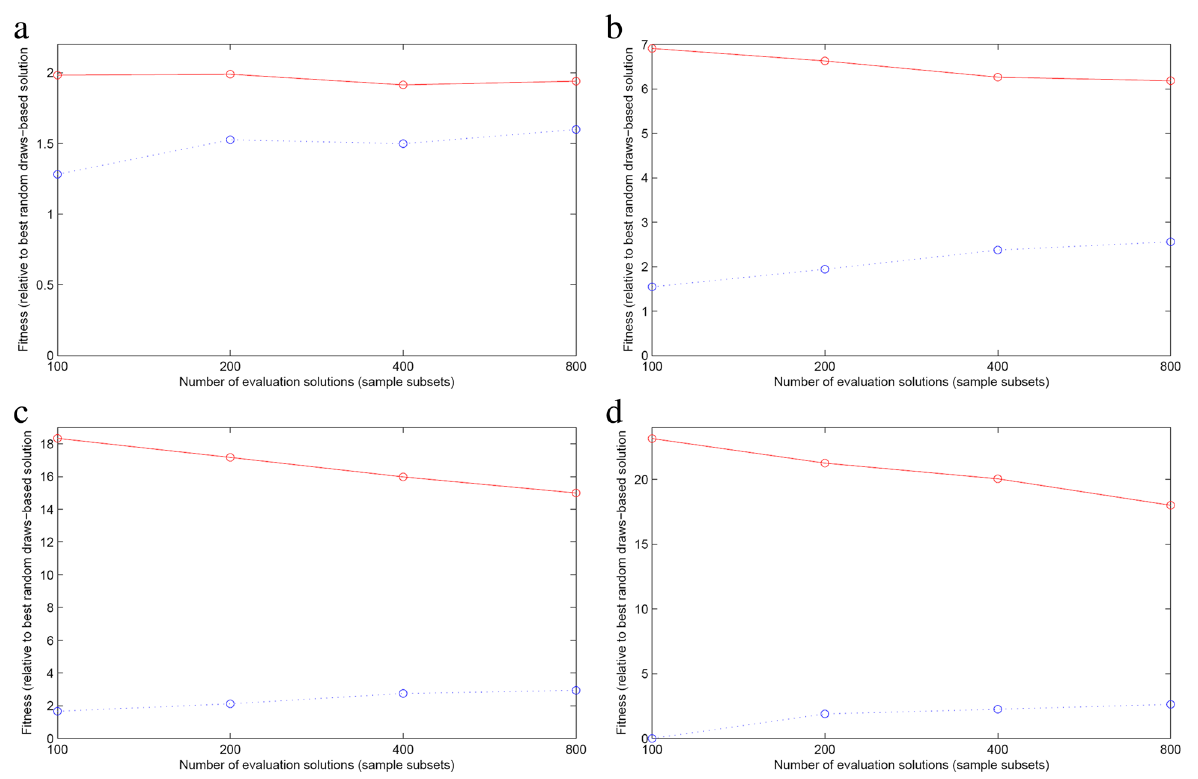
Fig. 2 Comparative performance of different sample selection methods on information loss. Each plot shows the average fitness of the methods described in Section 2.4 (solid red line) and Section 2.3.2 (dotted blue line) relative to the simplest, baseline described in Section 2.2, and its variation as a function of the number of generated hypotheses. Different plots correspond to different sizes of the sample set selected for removal (from the total initial number of samples equal to 400). a n r = 50 (12.5% of data). b n r = 100 (25% of data). c n r = 150 (37.5% of data). d n r = 200 (50% of